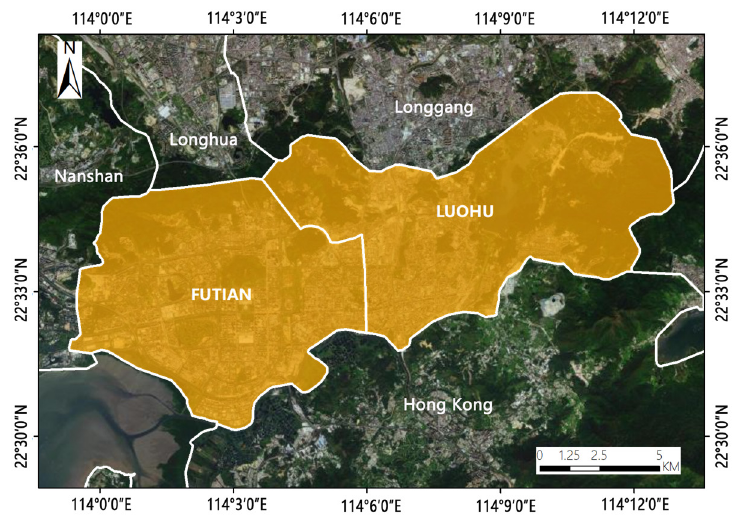
Figure 1. Schematic diagram of the study area.